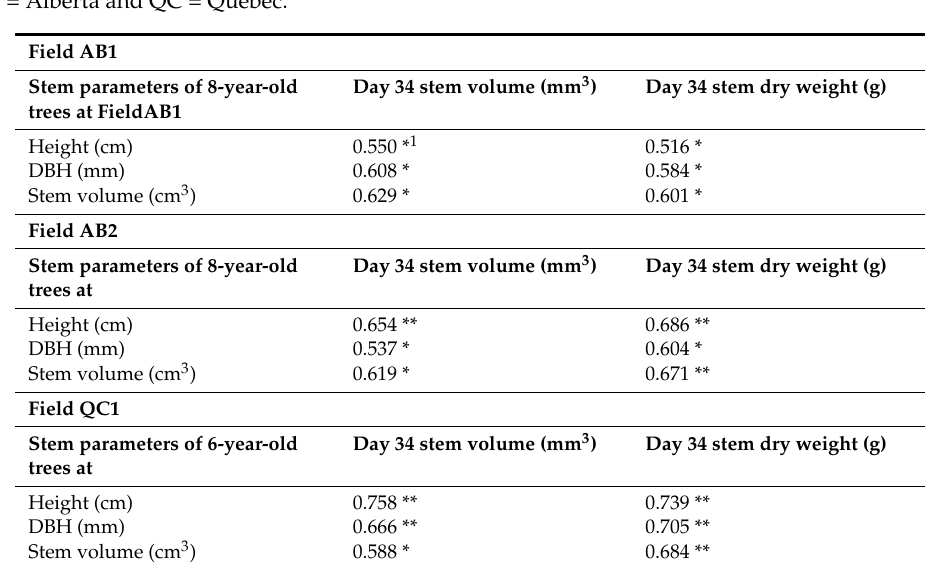
Figure 5. Pearson’s correlation (r) between field stem volume and greenhouse growth at Day 34 (after transplanting) for 15 selected progeny in 2017 for: ( a ) Year 8, Field AB1, AB; ( b ) Year 8, Field AB2, AB; and ( c ) Year 6, Field QC1, QC. Symbols represent individual progeny that had been previously grouped with FG ( ▲ ), SFG ( ■ ), and SG ( ● ). Note: SG = slow-growing progeny; SFG = slow-growing progeny from a fast-growing family; and FG = fast-growing progeny. AB = Alberta and QC = Quebec. Table 4. Pearson’s correlation (r) analysis between phenotypic characteristics of 8-year-old field-grown hybrid Populus balsamifera trees and Day 34 greenhouse-grown stecklings for the same 15 genotypes. AB = Alberta and QC =